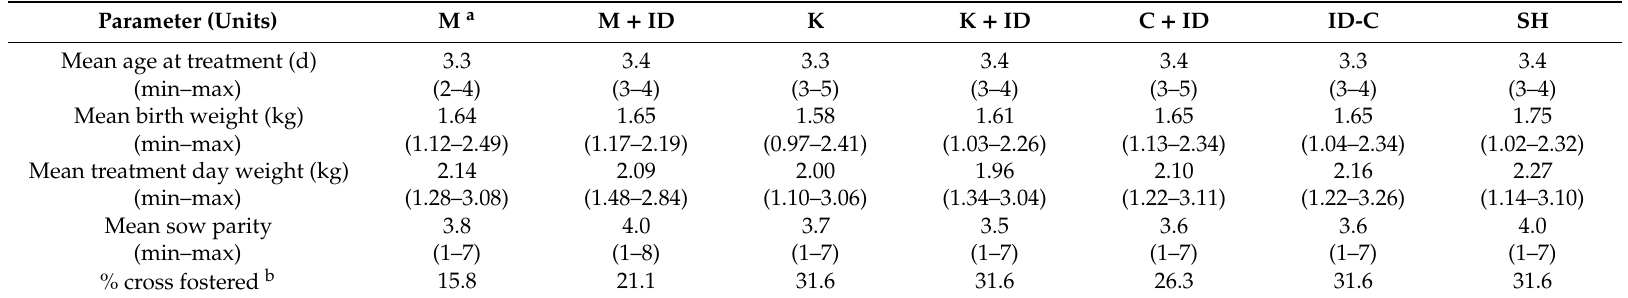
Table 1. Descriptive statistics of piglets ( n = 25 per group) on trial by treatment